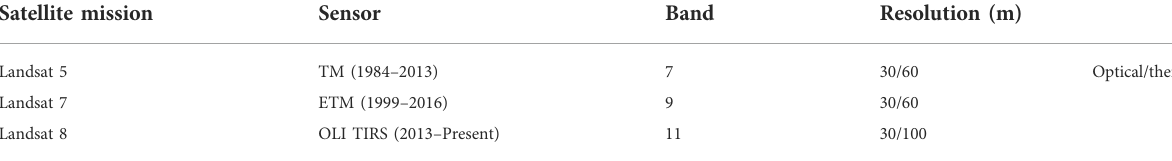
TABLE 1 Details of satellite images.